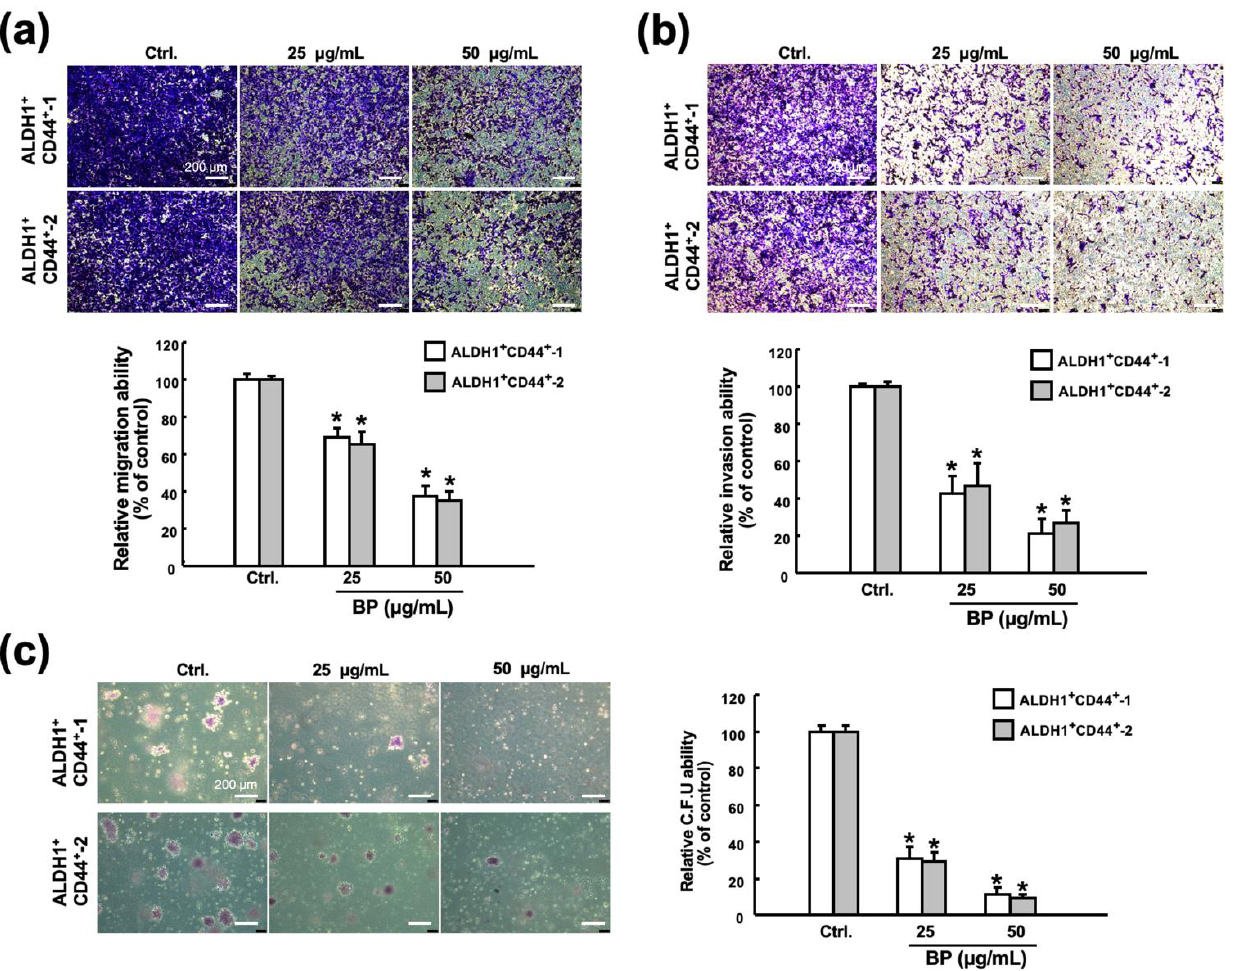
Figure 3. Butylidenephthalide eliminates the phenotypes of CSCs. The transwell culture system was employed to assess the ( a ) migration and ( b ) invasion capacities of two patient-derived ALDH1 + /CD44 + cells in response to butylidenephthalide treatment. ( c ) Colony forming ability of ALDH1 + /CD44 + cells was examined by clonogenic assay. Results are presented as means ± SD of three independent experiments; * p < 0.05 compared to Ctrl (control group containing 0.1% DMSO without butylidenephthalide). Butylidenephthalide (BP). Scale bar indicate 200 μm.